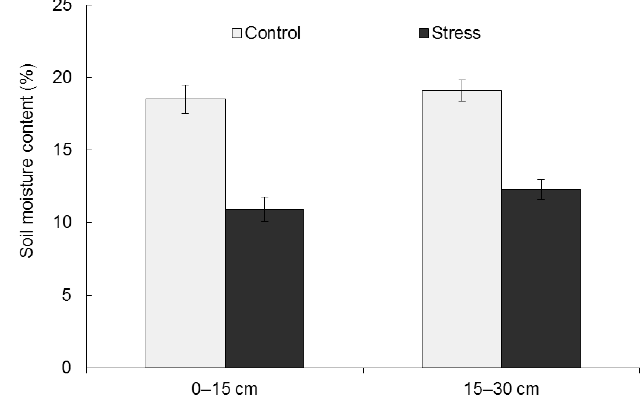
Fig. 1: Changes in soil moisture content (w/w) at different soil depth due to imposition of water deficit